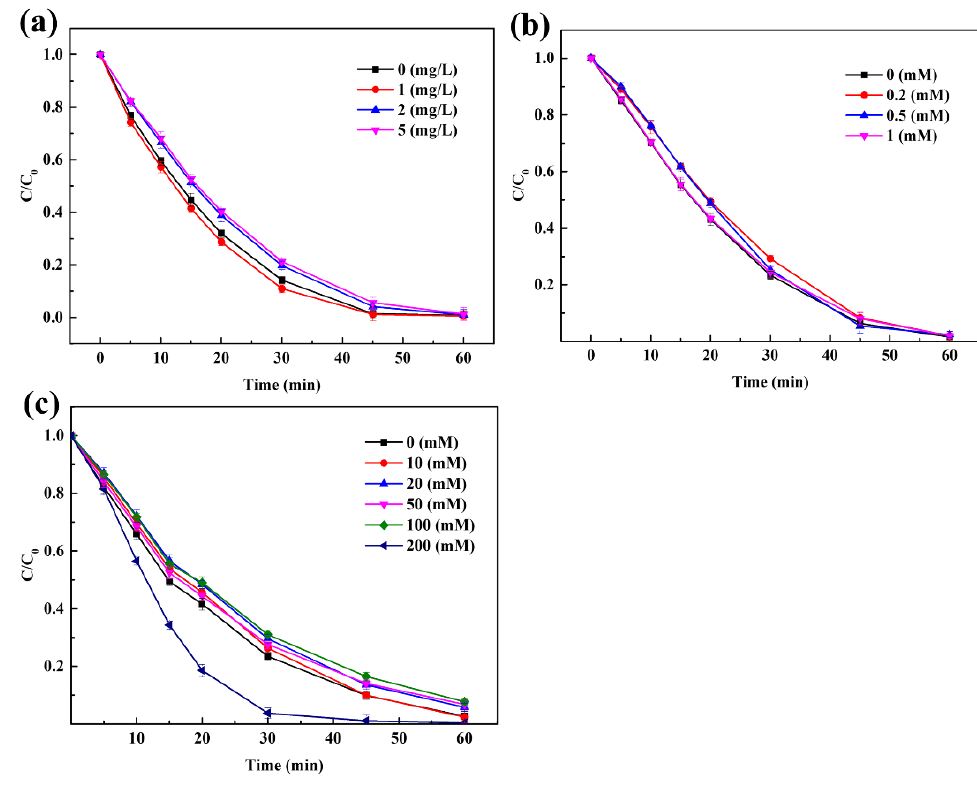
Figure 7. Effect of water matrices. ( a ) HA. ( b ) HCO 3 − . ( c ) Cl − (PAA = 80 mg/L, CuFe 2 O 4 = 100 mg/L, pH = 7, C 0 = 20 mg/L, room temperature for 1 h).